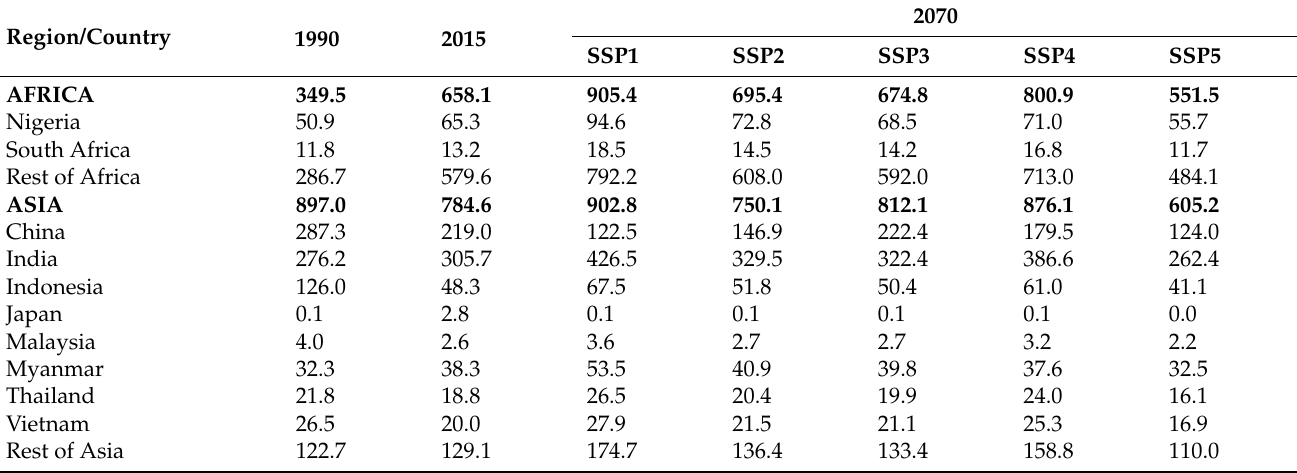
Table A3. Fuelwood consumption (million m 3 ), 1990 to 2015 historic, 2070 projections from